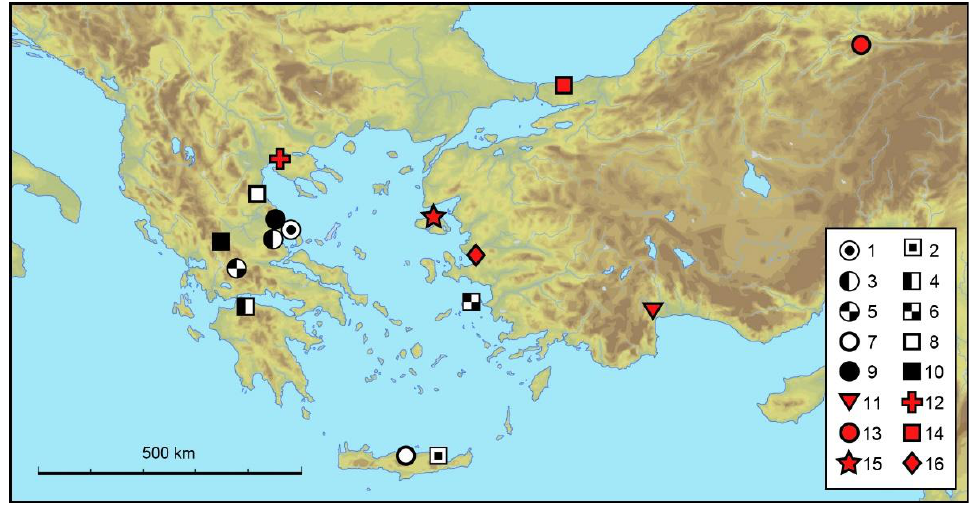
Figure 7. Distribution map of genera Iason and Parvocaecus . 1: I. argonauta ; 2: I. assingi ; 3: I. beroni ; 4: I. fulvii ; 5: I. karametasi ; 6: I. lompei ; 7: I. minoicus ; 8: I. olympicus ; 9: I. paglianoi ; 10: I. rossii ; 11: P. ana-